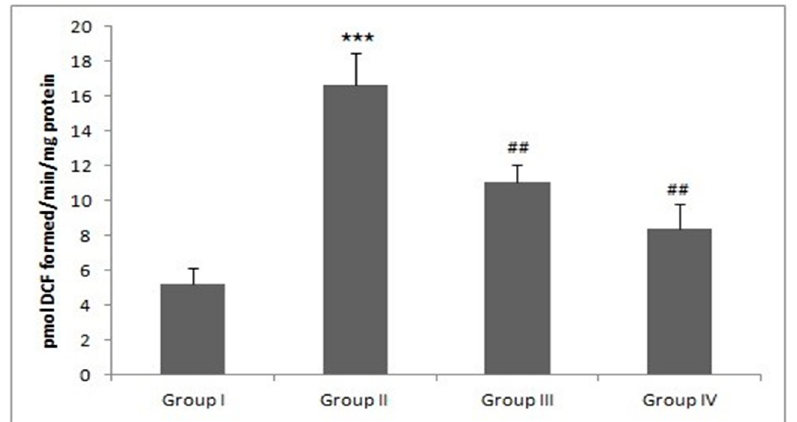
Figure 5. Piperine treatment mitigates ROS. In DMH-administered group-II, a tremendous amount